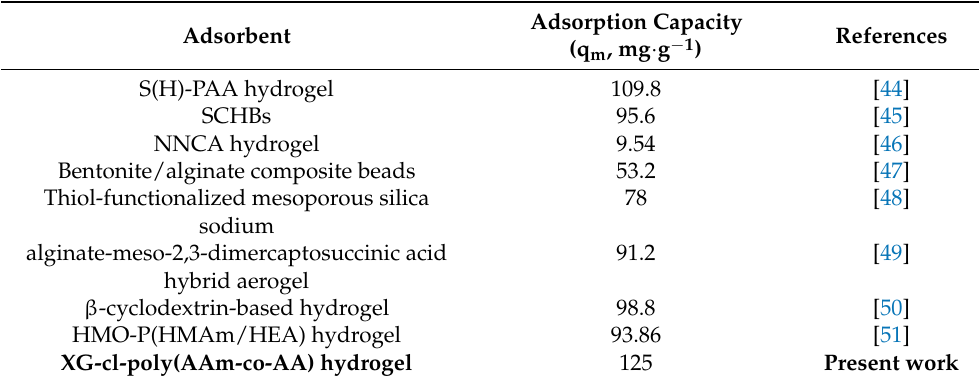
Table 3. Comparison of monolayer adsorption capacity of XG-cl-poly(AAm-co-AA) hydrogel with other adsorbents reported in the literature for Cd(II)